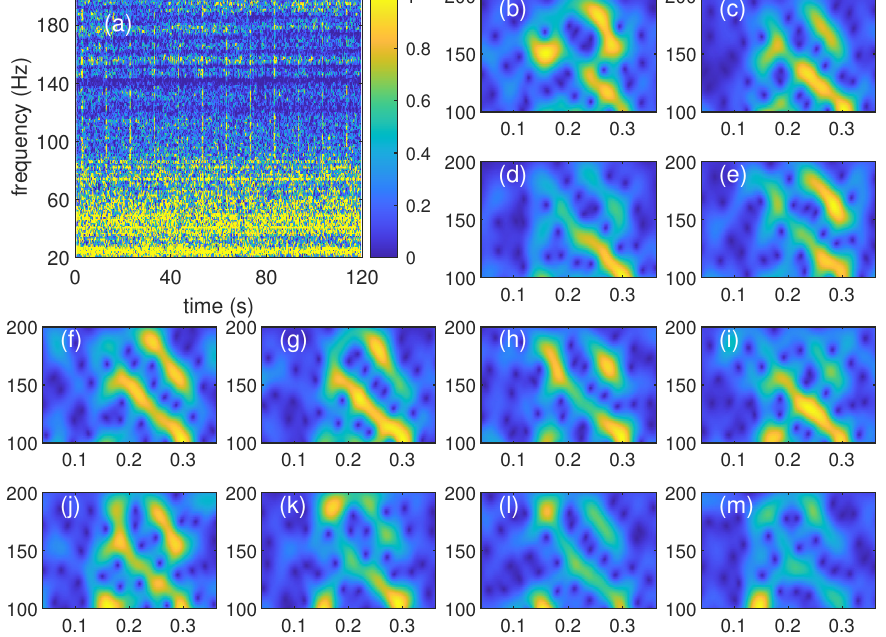
Figure 7. ( a ) The normalized STFT spectrogram of the received 5th group signals after source deconvolution (14.7 km source site). ( b – m ) The normalized STFT spectrogram of each signal in the 5th group.